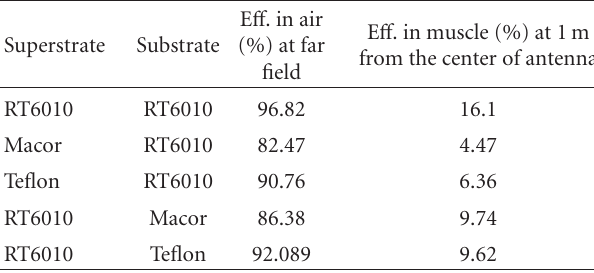
Table 2: Calculated e ffi ciency.